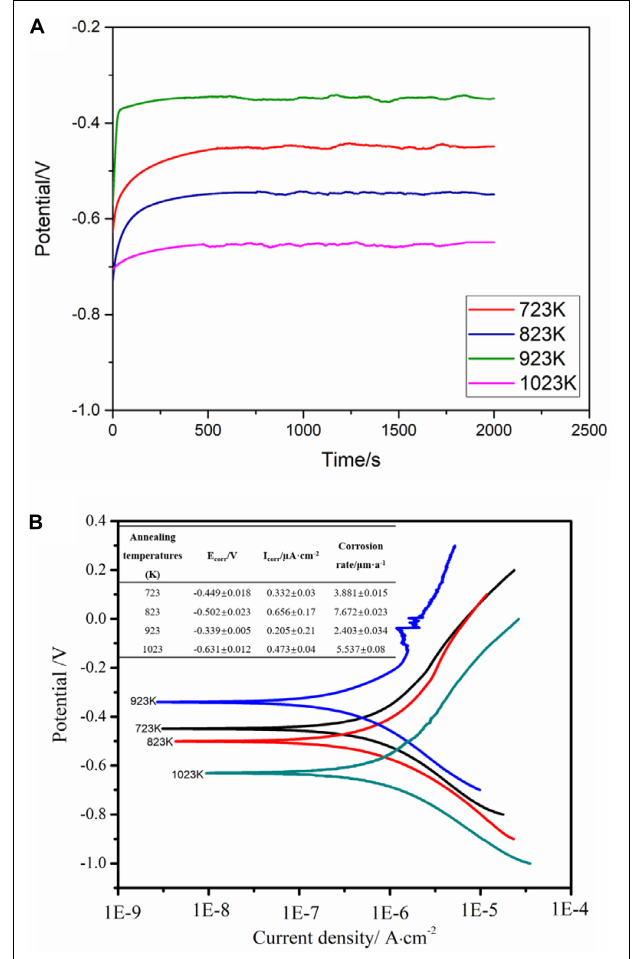
FIGURE 9 | (A) Open circuit potential curves and (B) potentiodynamic polarization curves of the samples at different annealing temperatures.